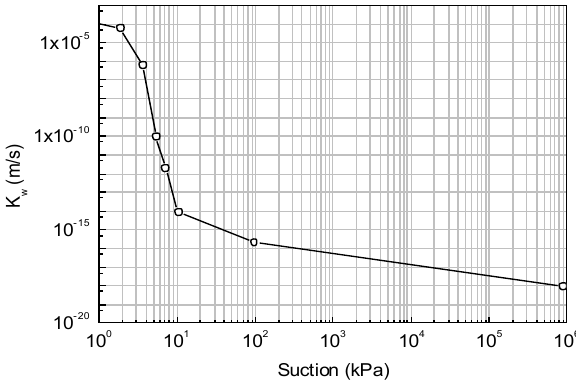
Figure 2a. Hydaulic properties of the Beaver Creek sand (Gitirana et al. 2005) Fig. 2a. Hydaulic properties of Beaver Creek sand (Gitirana et al.,